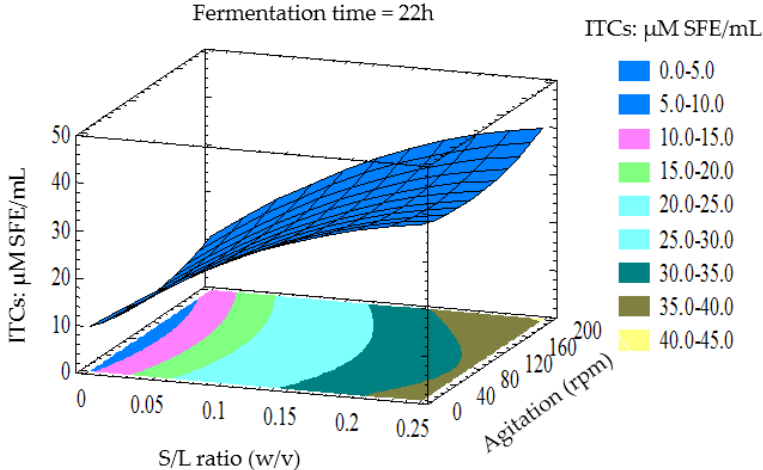
Figure 1. Three-dimensional response surface plot showing the effect of S/L ratio and agitation rate (rpm) on ITCs yield (ITCs: μM SFE/mL) when the response surface is fixed at fermentation time 22 h.